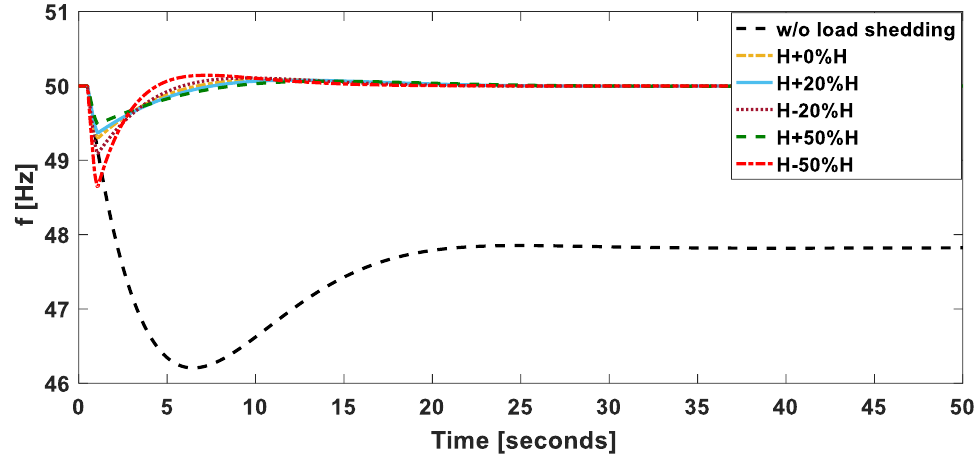
Figure 17. Frequency behavior of the proposed UFLS technique under uncertainties in estimating the total inertia, H, in SFR